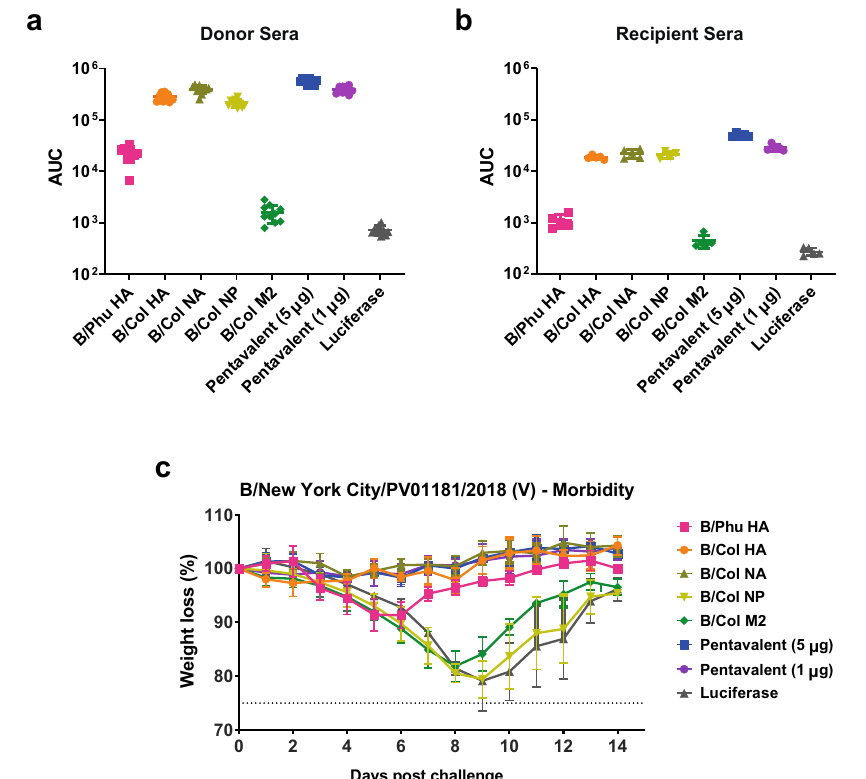
Fig. 9 | Humoral protection from IBV challenge is afforded by antibodies that target glycoproteins. Mice were vaccinated twice (with a 4-week interval) I.D. with 5 µ g of mRNA-LNPs. Sera were collected from vaccinated animals 4weeks after the boost and then assessed for antibody reactivity towards B/Colorado/ 06/2017 (V) in fl uenza virus-infected cells ( n =10 mice/group) ( a ). Sera from vaccinated mice were transferred into naïve mice. Two hours after the transfer, sera from naïve recipients of passive sera were assessed for antibody reactivity towards B/Colorado/06/2017 (V) in fl uenza virus-infected cells ( n =5 mice/